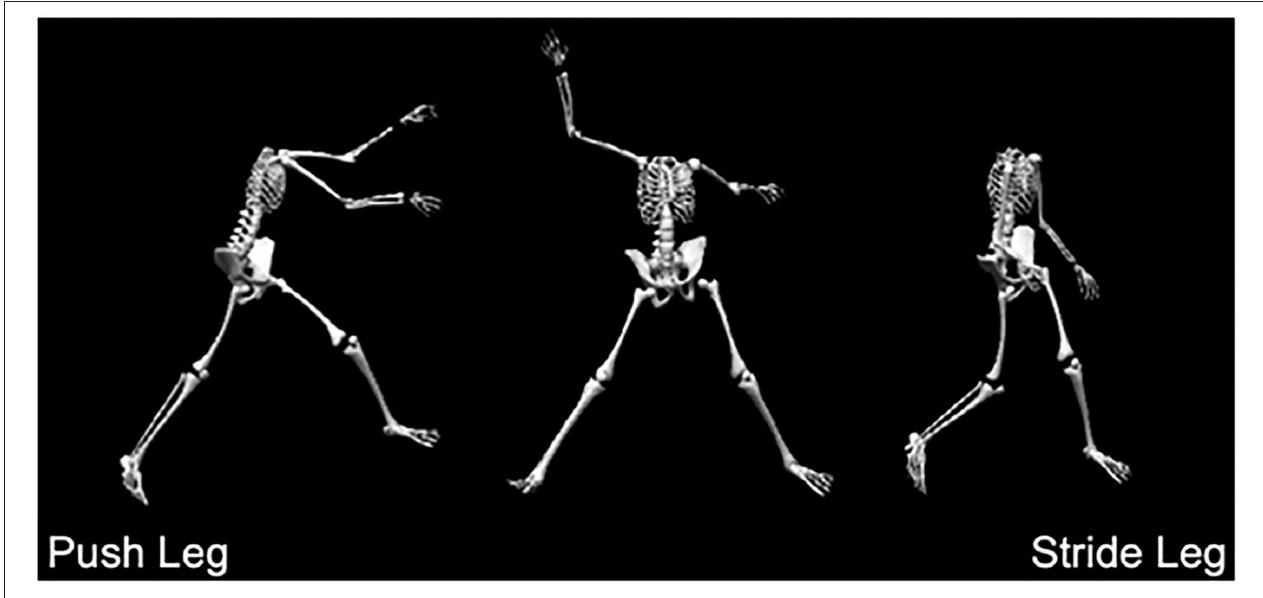
FIGURE 1 | Push and stride leg illustration during the windmill